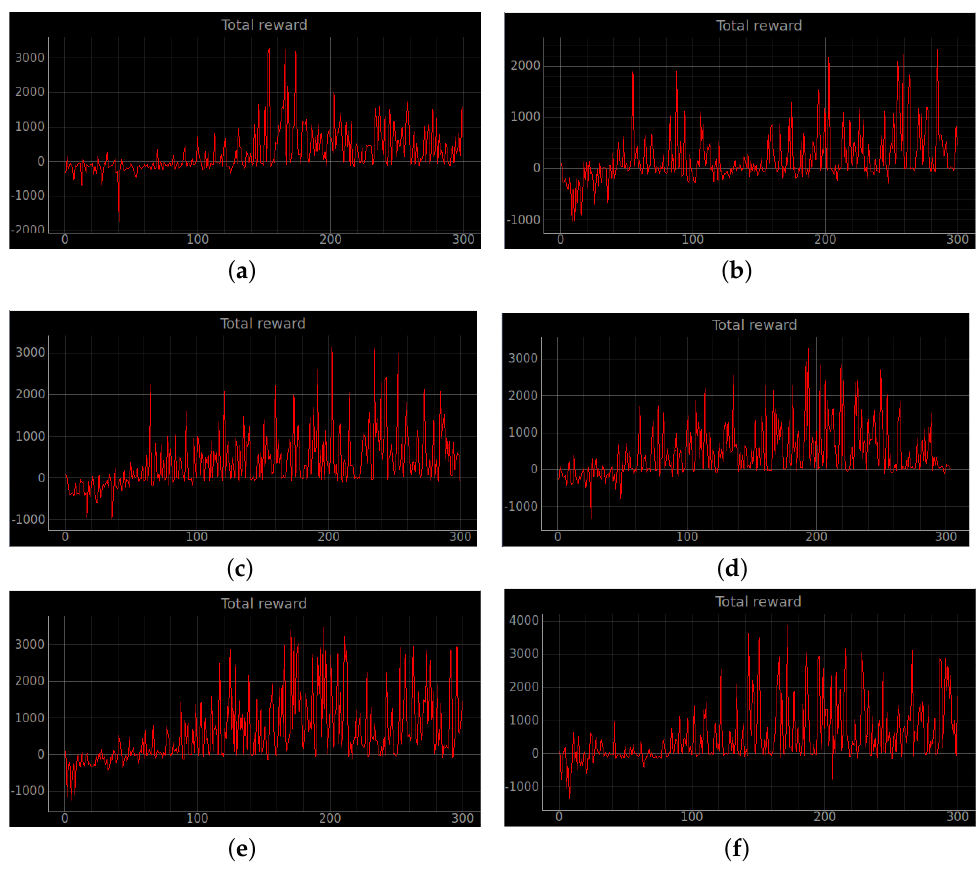
Figure 10. The curve of the cumulative sum of all rewards per episode for stage 3. ( a ) Original DQN;